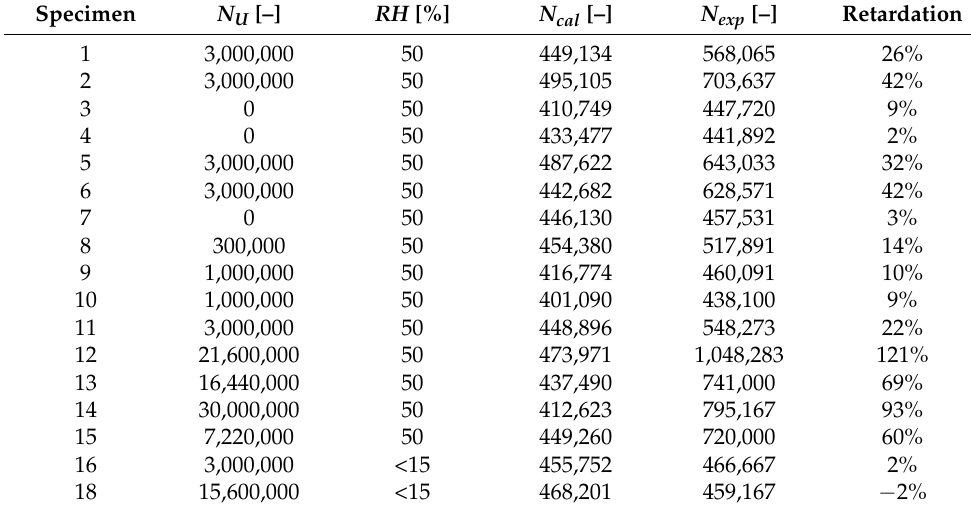
Table 5. Numbers of base load cycles needed for crack increment of 1.0 mm with ( N exp ) and without ( N cal ) the effect of underload